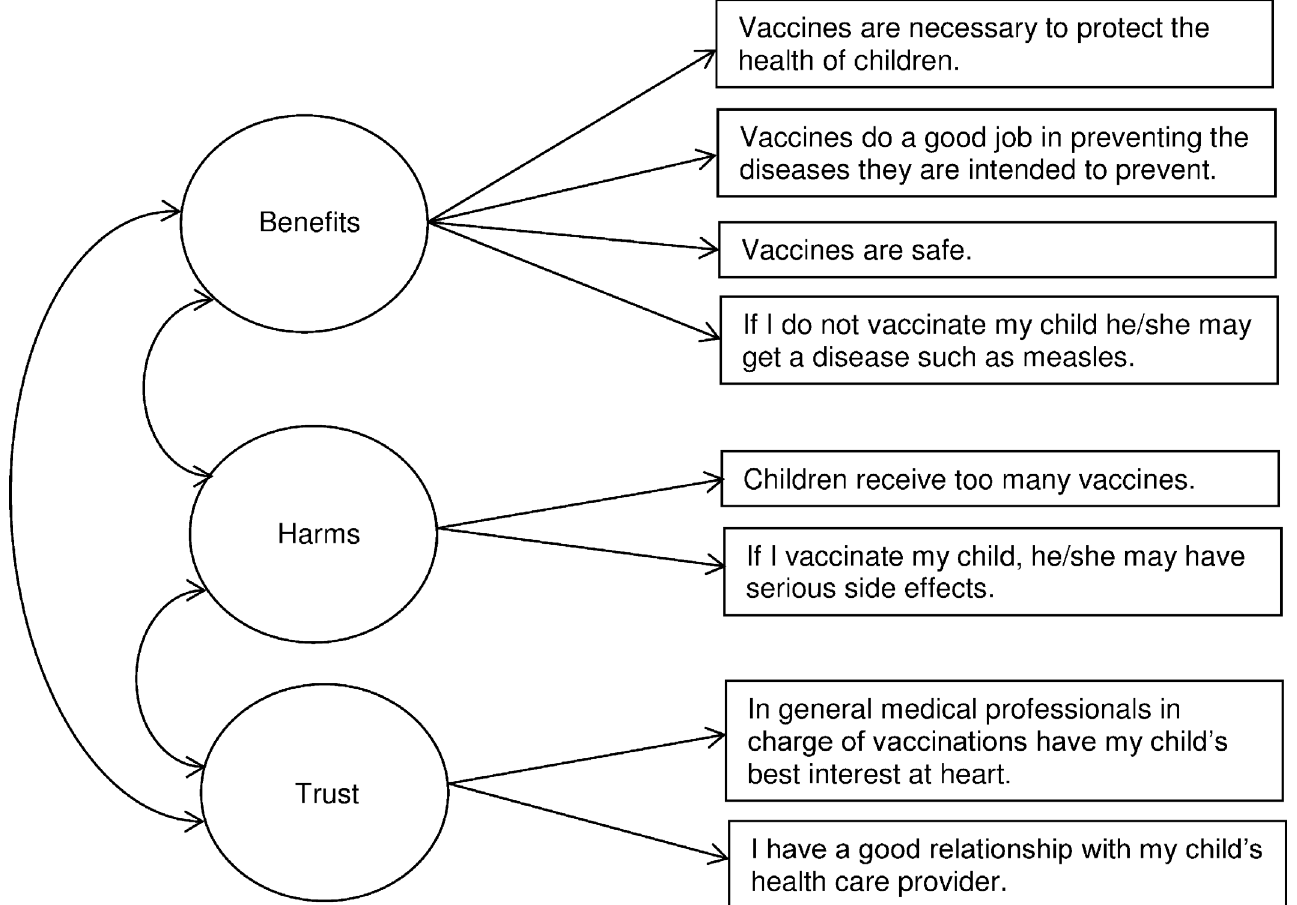
Fig 1. The Vaccination Confidence Scale as modified for early childhood